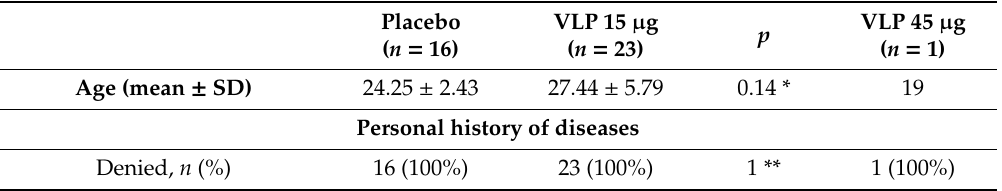
Table 1. Characteristics of the study population